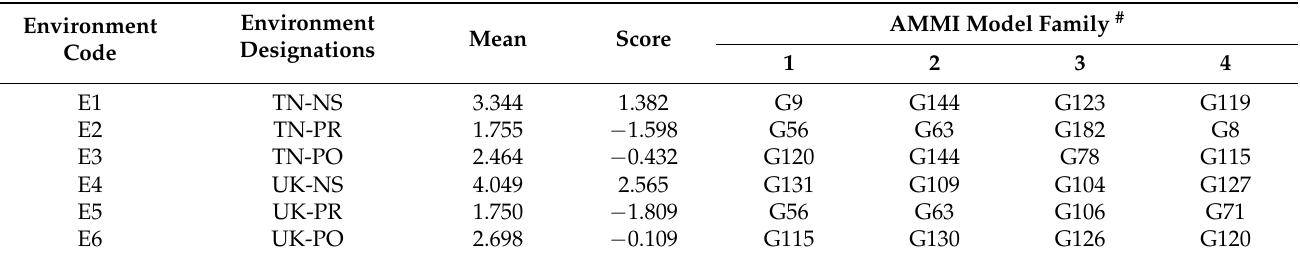
Table 7. Winning sorghum genotypes for grain yield based on additive main effects and multiplicative interaction (AMMI) model families.